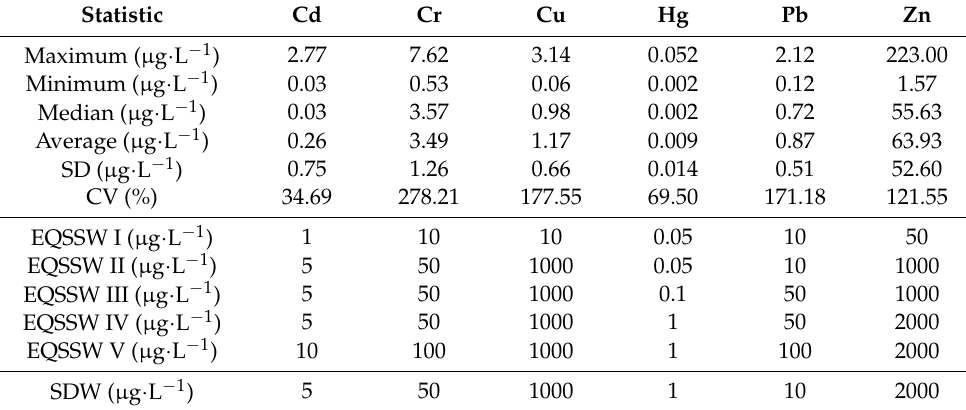
Table 3. Statistics for six heavy metals in surface water in study